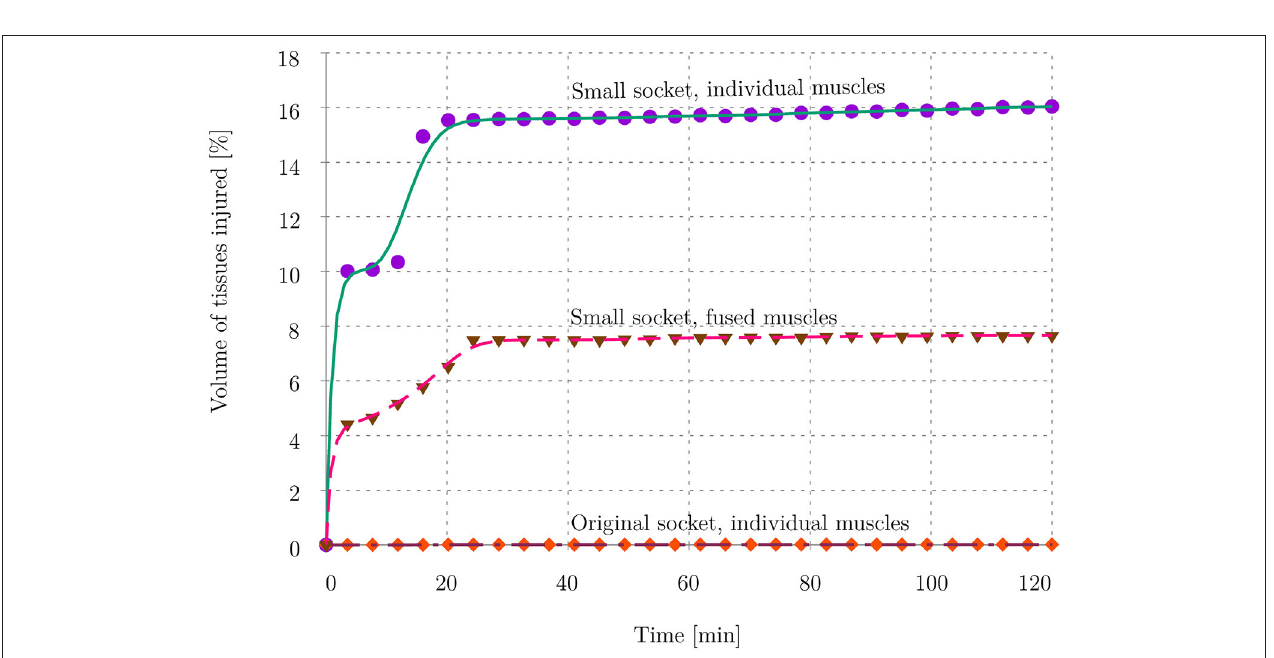
FIGURE 13 | Volume ratio of injured tissues. The plot shows the volume of muscle tissues that was affected by deep tissue injury as a percentage of total muscle volume in the residual limb. The evolution of tissue damage for all 3 cases is plotted here.